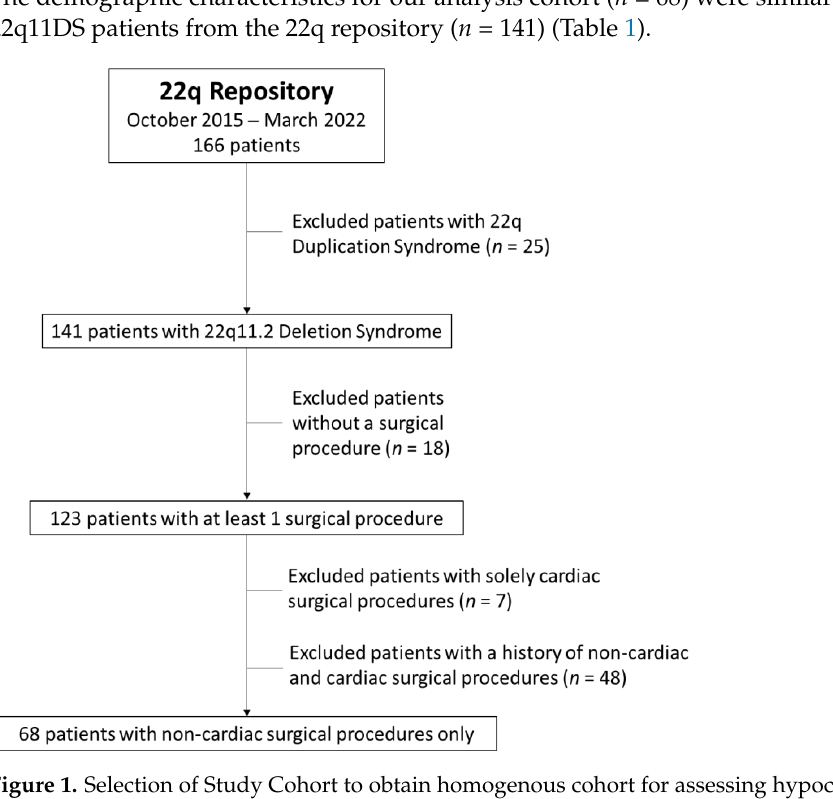
Figure 1. Selection of Study Cohort to obtain homogenous cohort for assessing hypocalcemia. Table 1. Clinical